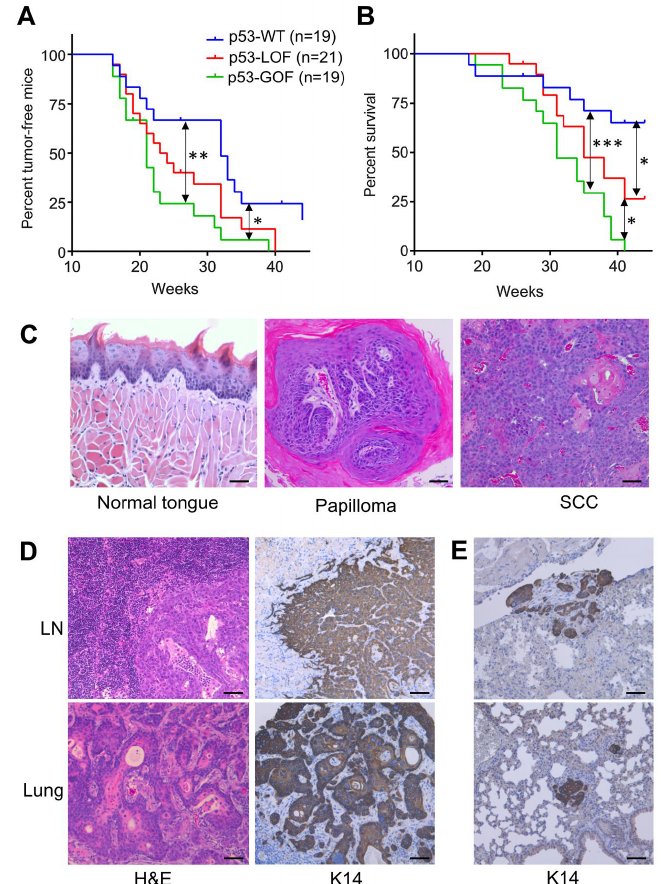
Figure 1. Mutant p53 R172H promotes metastasis in oral tumors initiated by 4-Nitroquinoline 1-oxide (4NQO). ( A ) Kinetics of 4NQO-induced oral tumor development in mice with the indicated p53 genotypes. ( B ) Survival of mice with 4NQO-induced oral tumors that differ on their p53 status. ( C ) Representative images of the normal tongue epithelium, benign papillomas, and squamous cell carcinomas (SCCs) that developed in mice upon 4NQO treatment. Bar = 100 µ m. ( D ) H&E staining of metastasis that developed in lymph nodes (LN) and lung (left panels), and their respective K14 staining (right panels). Bar = 100 µ m. ( E ) K14 staining for two independent lung samples showing the presence of micrometastasis. Bar = 100 µ m. * p < 0.05, ** p < 0.01, *** p <